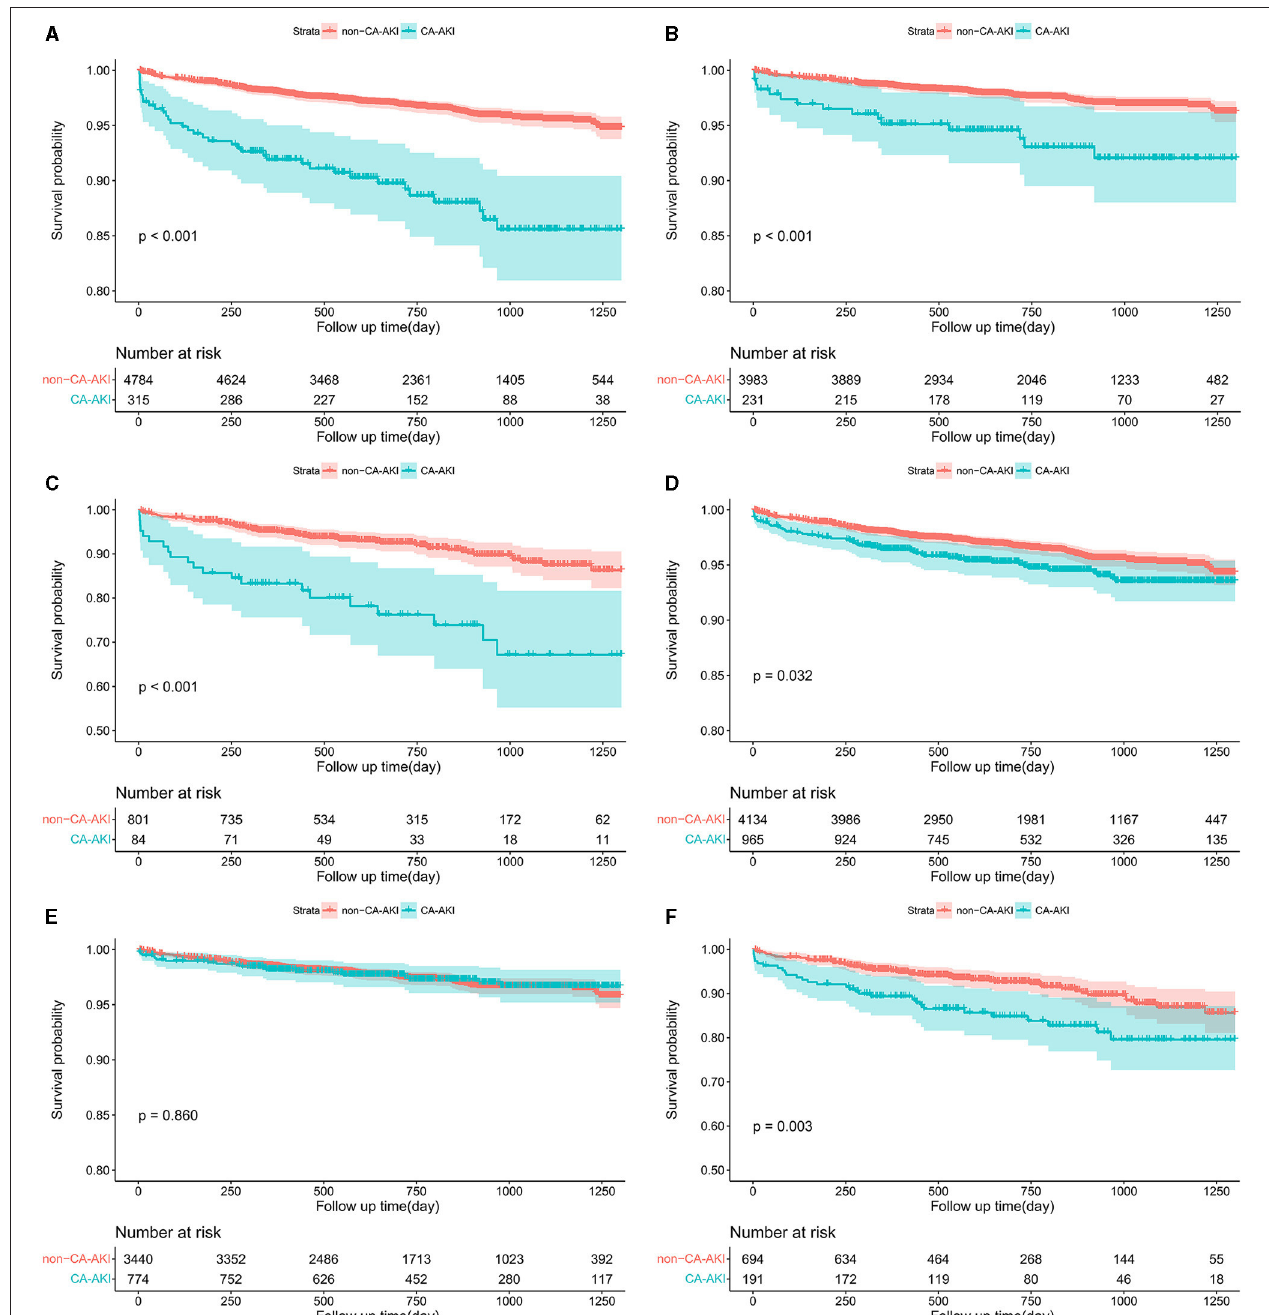
FIGURE 4 | Kaplan–Meier curves for long-term mortality according to the AKIN definition in the overall population (A) , patients ≤ 75 years (B) , and patients > 75 years (C) and according to the ESUR definition in the overall population (D) , patients ≤ 75 years (E) , and patients > 75 years (F) . CA-AKI, contrast-associated acute kidney injury; AKIN, Acute Kidney Injury Network; ESUR, European Society of Urogenital Radiology.